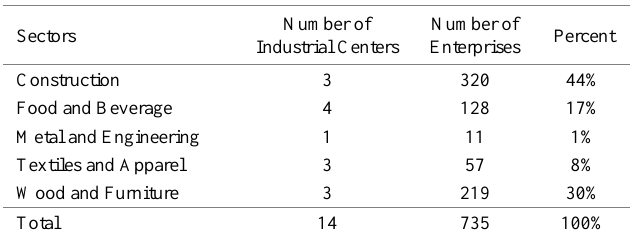
Table 1. Statistics of the